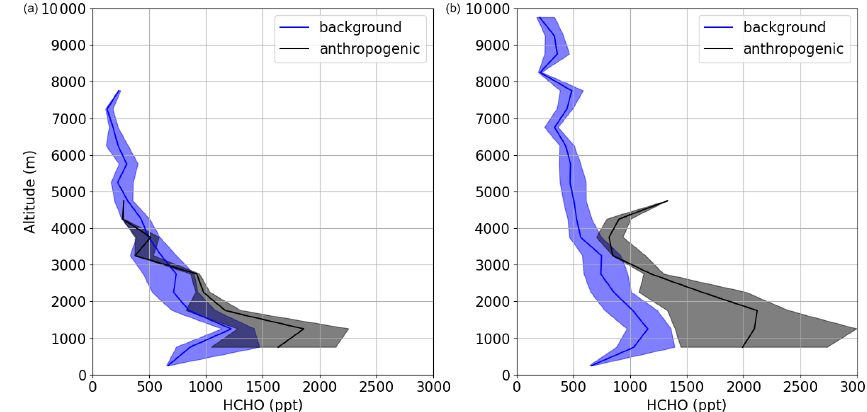
Figure 15. Vertical profiles of HCHO (miniDOAS, a ; HKMS, b ) for pure anthropogenic emissions (C 6 H 6 enhancement in absence of CH 3 CN) and background air (in the absence of C 6 H 6 and CH 3 CN). Shaded areas are the quartiles; solid lines represent median concentra- tions.